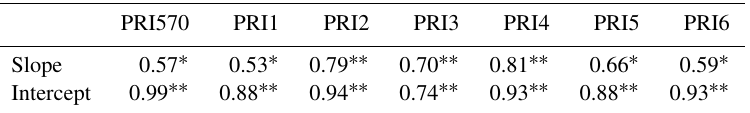
Table 4. R 2 of the quadratic function between shaded-leaf fractions and the slope and intercept of the linear regression models that are used to estimate RWC with different formulations of PRI.